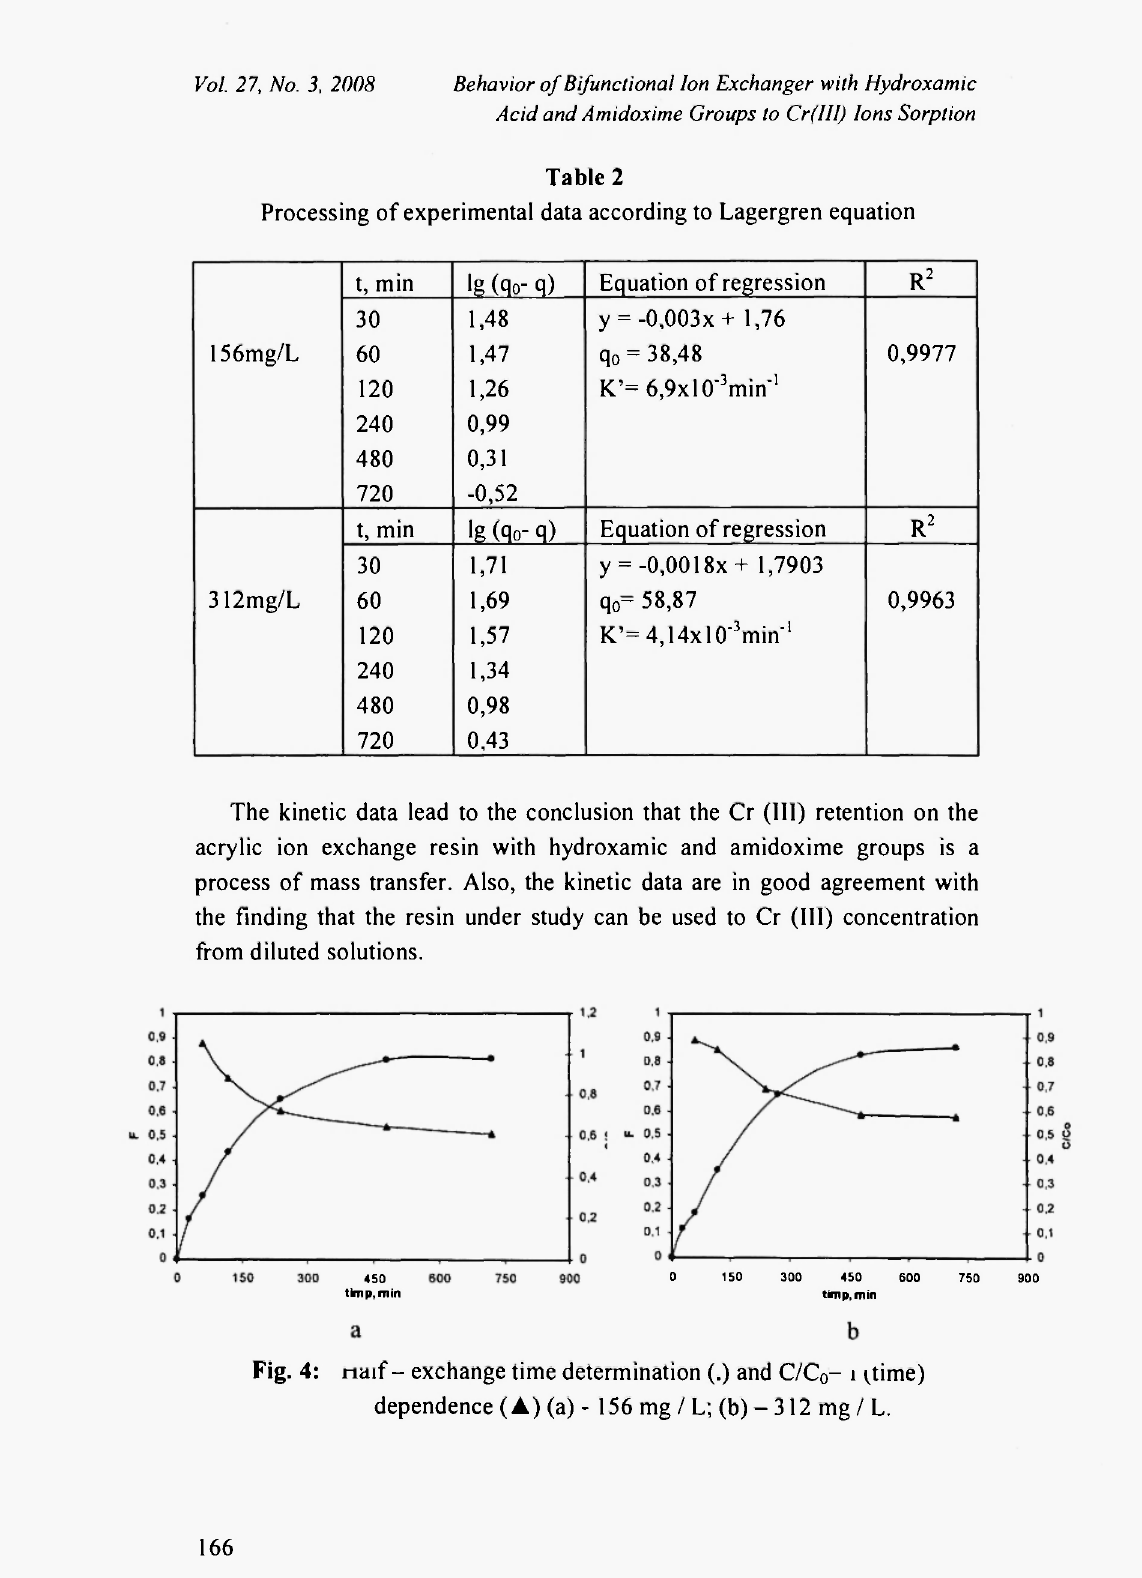
Fig. 4: n a i f- exchange time determination (.) and C/C 0 - ι